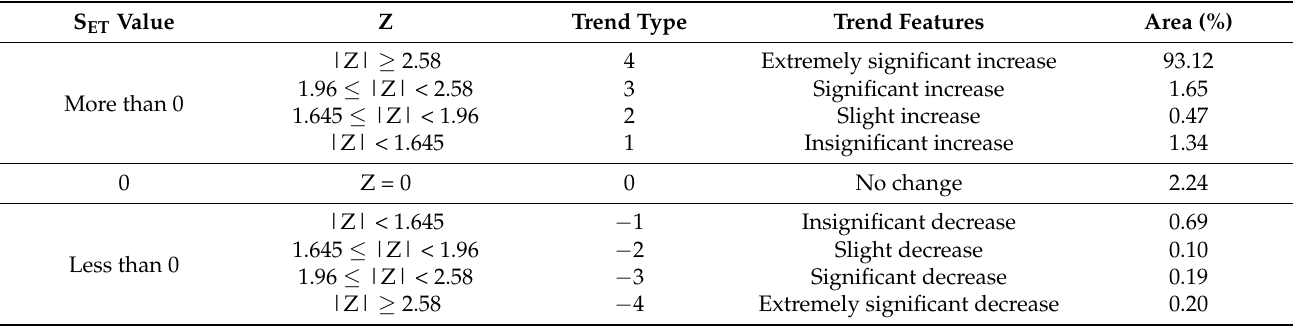
Table 1. Statistics of ET trends in Ningxia from 2001 to 2020.